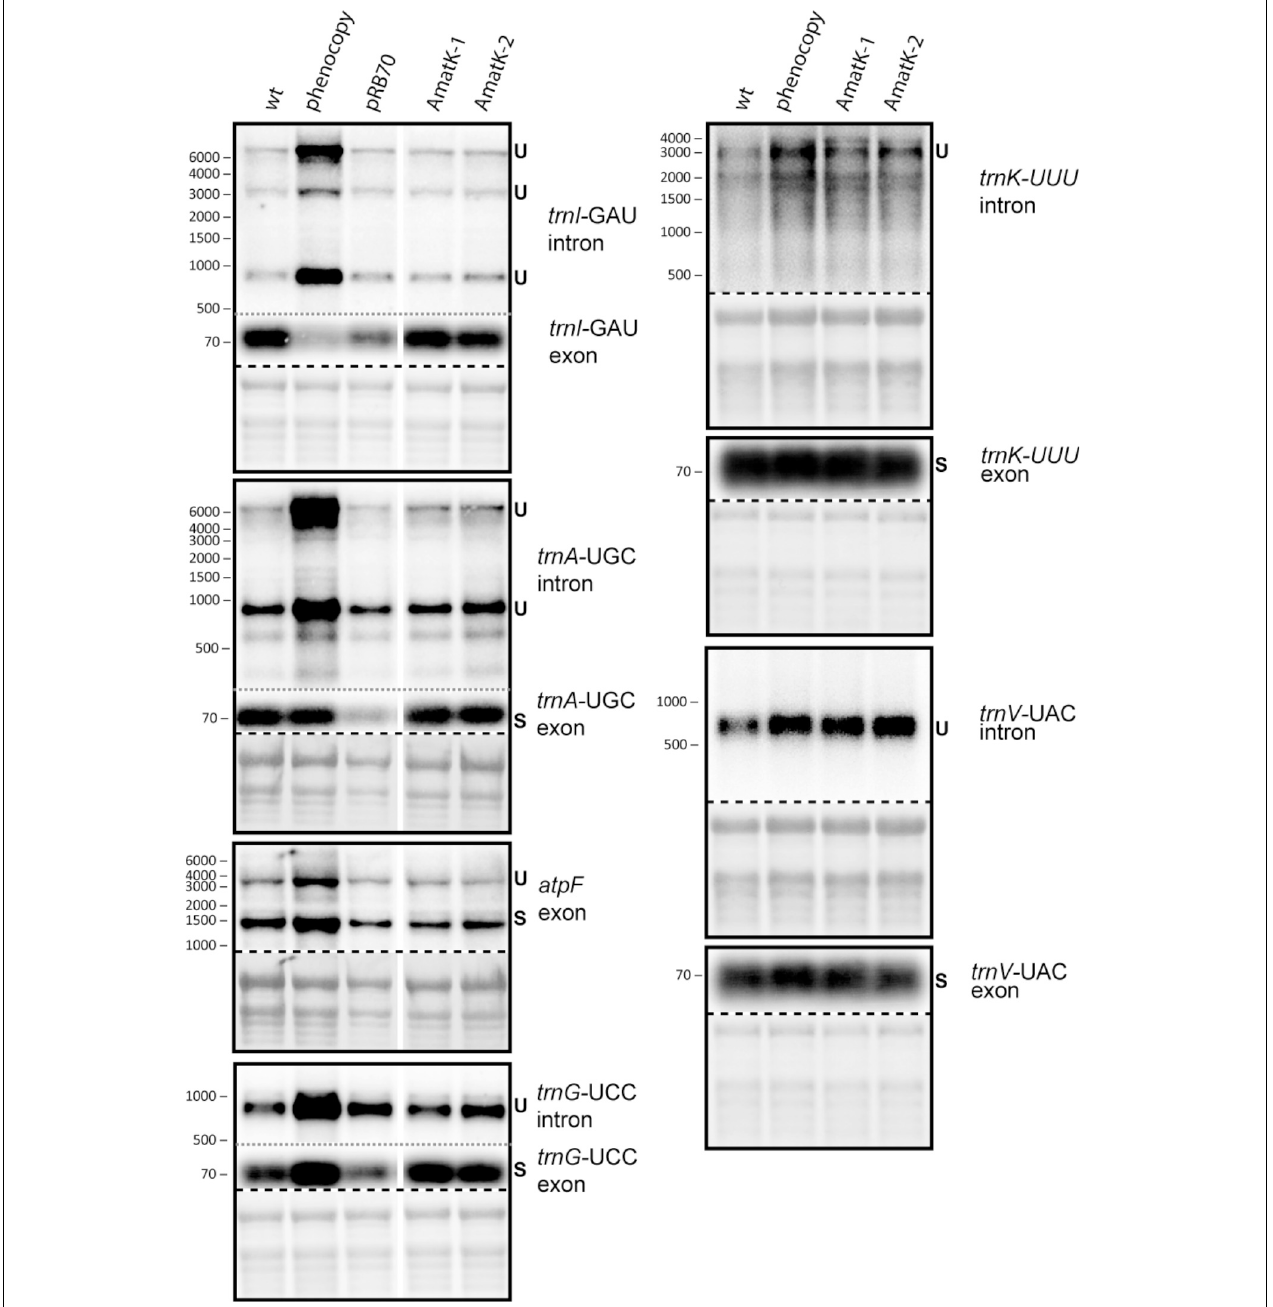
FIGURE 5 | Analysis of RNA splicing in AmatK and control plants. 5 µ g of total leaf RNA was separated on 1.2% agarose gels and analyzed by hybridization to probes specifying target RNAs of MatK (see Supplementary Table S1 online for primer sequences). The following RNA samples were analyzed: RNA from AmatK, aadA , wt plants, and wt plants trested with spectinomycin (phenocpy control). Methylene blue staining identifies rRNAs and was carried out prior to hybridization. The autoradiographs and the corresponding methylene blue stains (below) are separated by a dashed line. Note that exon probings for trnG , trnA, and trnI were done after the respective intron probings on the same blots (separated by gray, dotted lines). White vertical lines indicate, where irrelevant lanes have been removed.